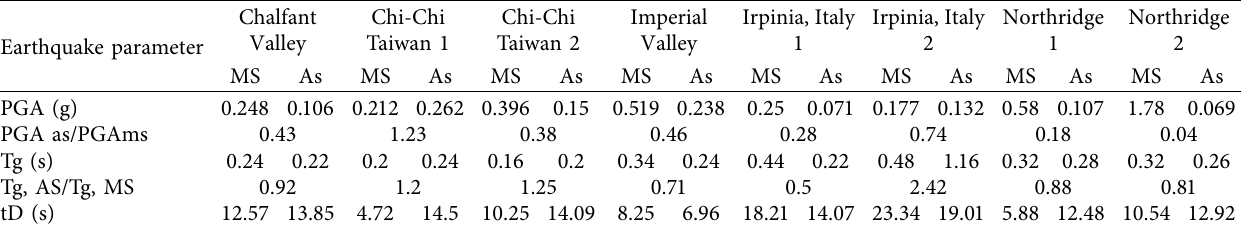
Table 17: Parameters and efective characteristics in the response of models under Group II (nearly maximum EPA). Earthquake parameter